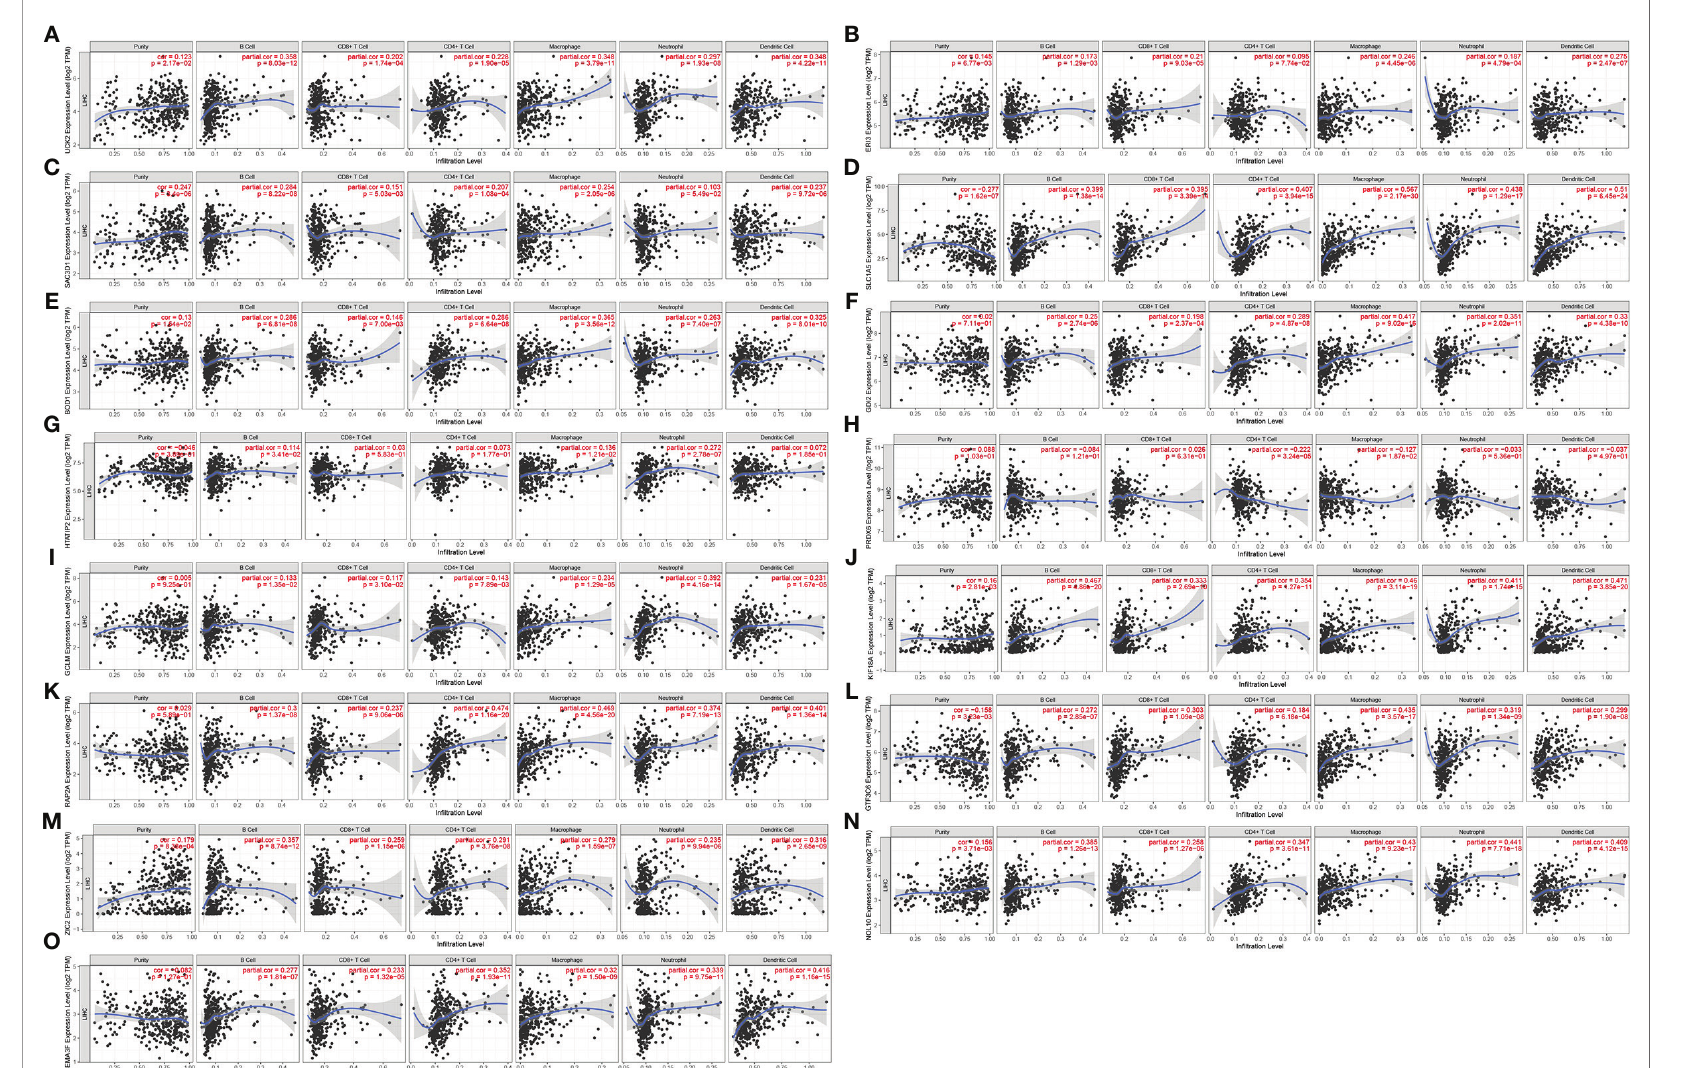
FIGURE 7 | Correlation of 15 gene signatures with immune cell in fi ltration [ (A) UCK2 correlates with immune cell in fi ltration; (B) ERI3 correlates with immune cell in fi ltration; (C) SAC3D1 correlates with immune cell in fi ltration; (D) SLC1A5 correlates with immune cell in fi ltration; (E) BOD1 correlates with immune cell in fi ltration; (F) GDI2 correlates with immune cell in fi ltration; (G) HTATIP2 correlates with immune cell in fi ltration; (H) PRDX6 correlated with immune cell in fi ltration; (I) GCLM correlated with immune cell in fi ltration; (J) KIF18A correlated with immune cell in fi ltration; (K) RAP2A correlated with immune cell in fi ltration; (L) GTF3C6 correlated with immune cell in fi ltration; (M) ZIC2 correlated with immune cell in fi ltration; (N) NOL10 correlated with immune cell in fi ltration; (O) . SEMA3F correlated with immune cell in fi